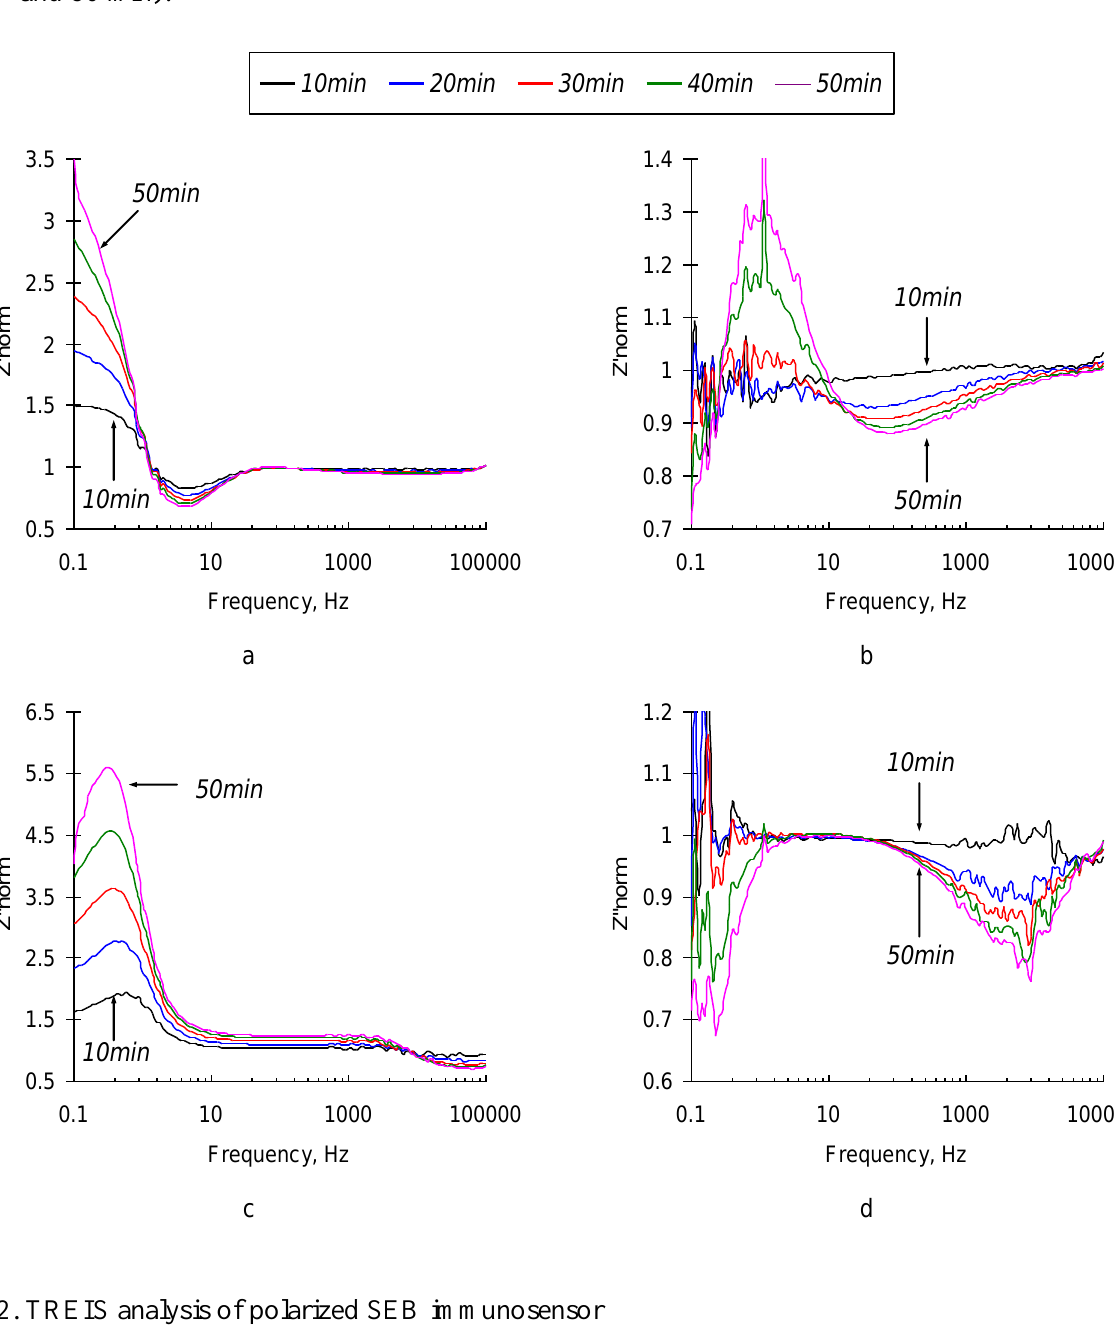
Figure 4. Normalized values of Z  (a,b) and Z  (c,d) parts of electrochemical impedance spectra of a non-polarized ( φ = –0.765 V vs. Ag/AgCl) SEB immunosensor in 0.3% NaCl (a, c) and 0.3% NaCl + 10  g/mL (b, d) as a function of time (10 min, 20 min, 30 min, 40 min, and 50